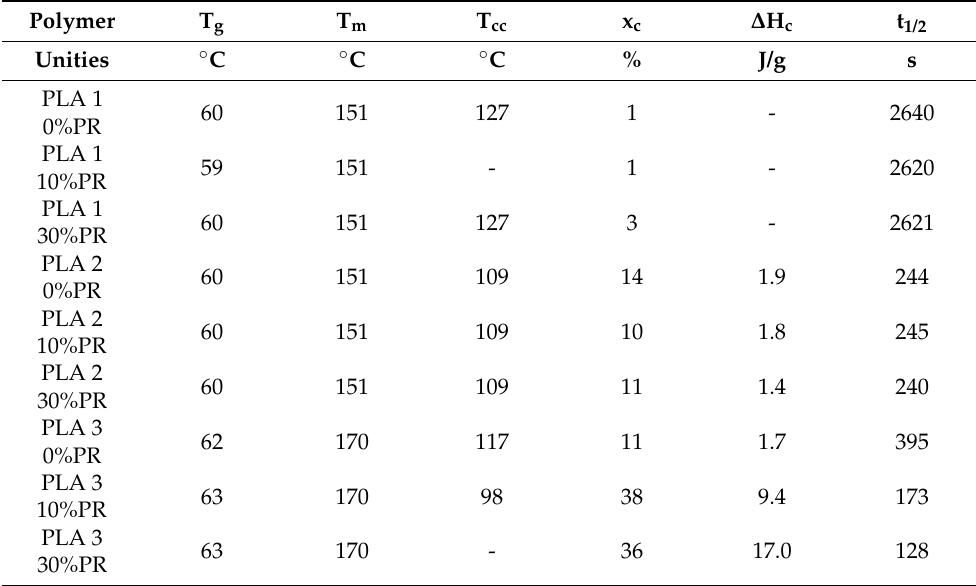
Table 5. Thermal parameters obtained with differential scanning calorimetry (DSC)